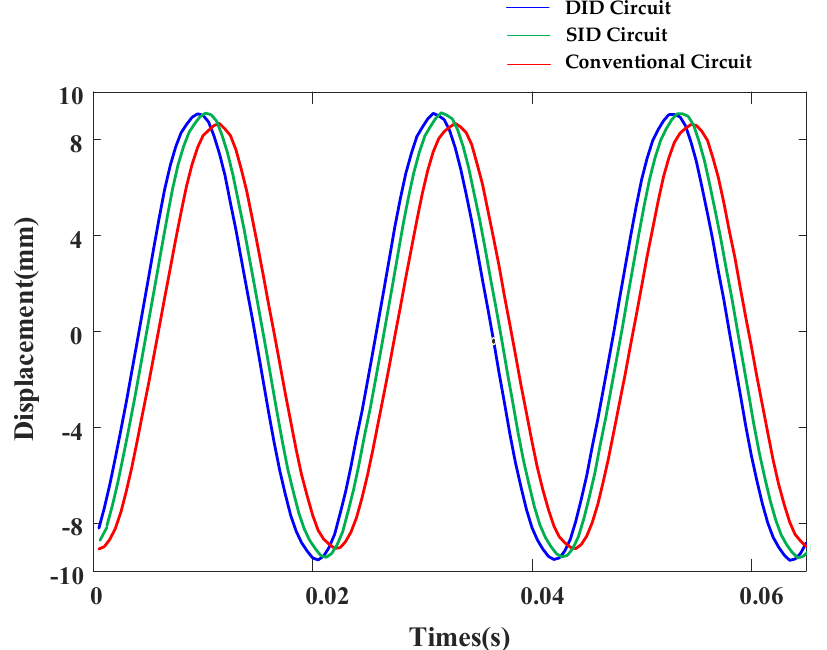
Figure 16. Vibration displacement of the PE fan.